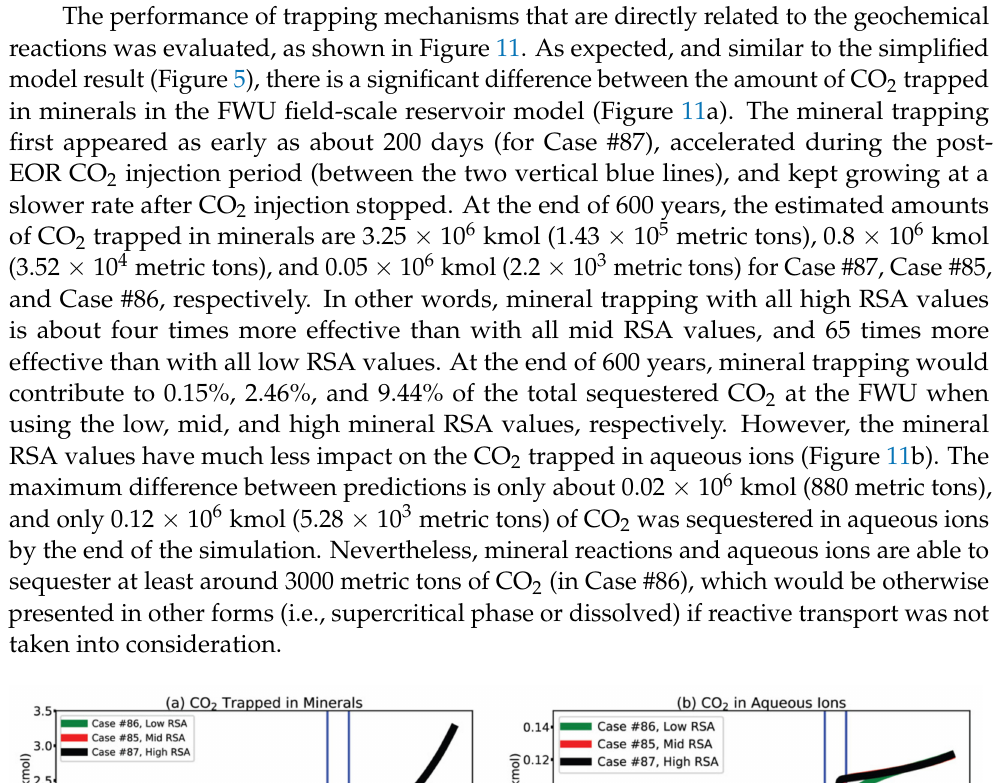
Figure 10. Simulated CO 2 global mole fraction at the end of the simulation period for ( a ) Case #86, ( b ) Case #85, and ( c ) Case #87.